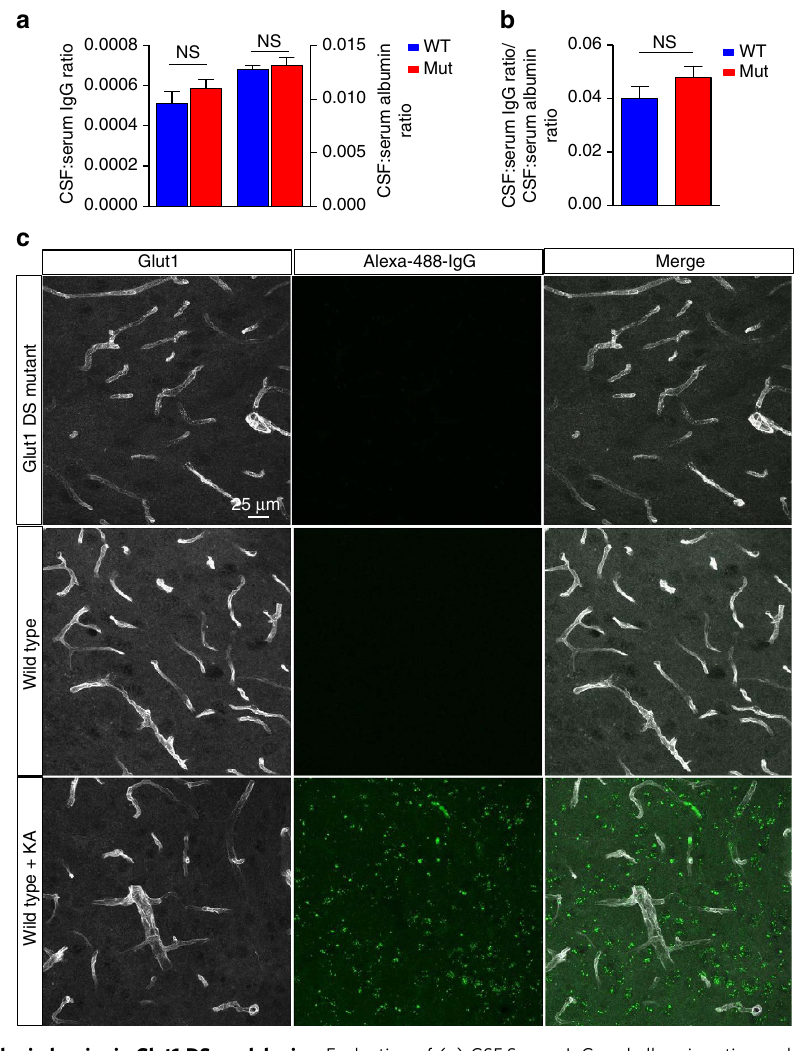
Figure 2 | An intact blood–brain barrier in Glut1 DS model mice. Evaluation of ( a ) CSF:Serum IgG and albumin ratios and ( b ) CSF index fails to provide evidence of any extravasation of serum proteins into the CSF of adult Glut1 DS mutant mice. P 4 0.05, t- test, N Z 4 mice of each genotype. ( c ) Labelled IgG systemically administered into Glut1 DS mutants does not escape into the neuropil. Note green fluorescence outside the microvasculature following chemically induced disruption of the